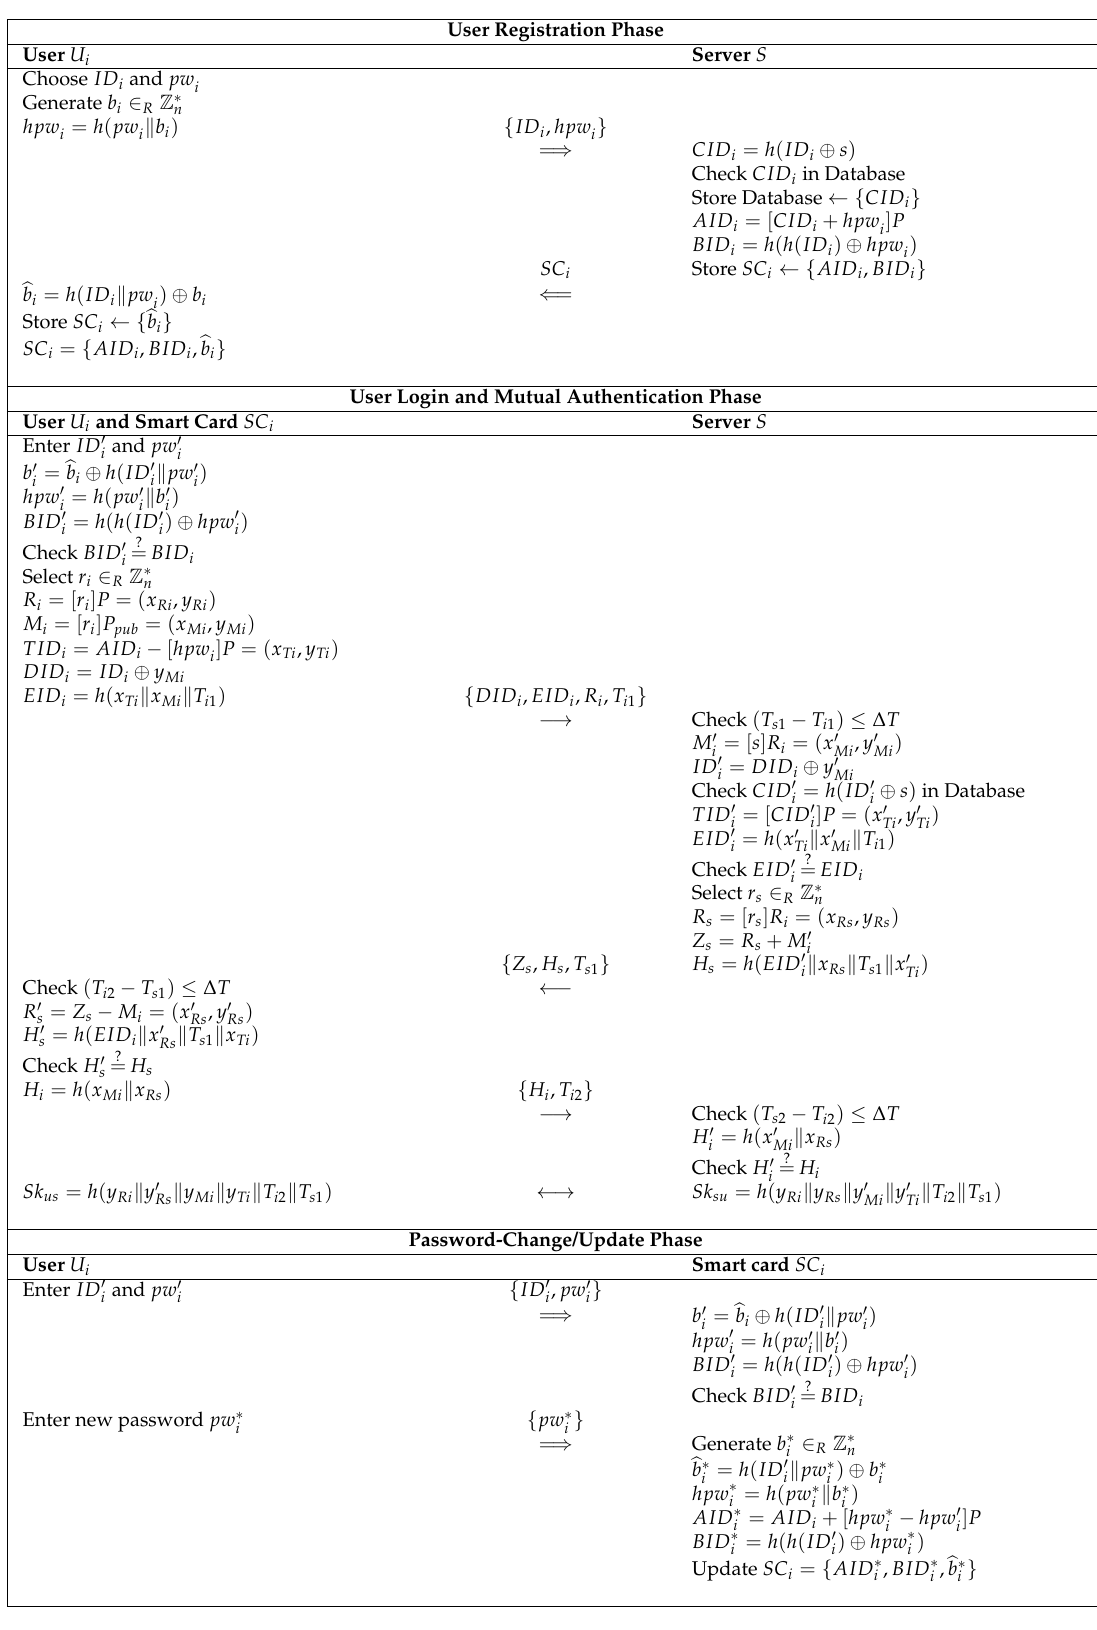
Figure 3. The proposed ECC-based remote user password authentication